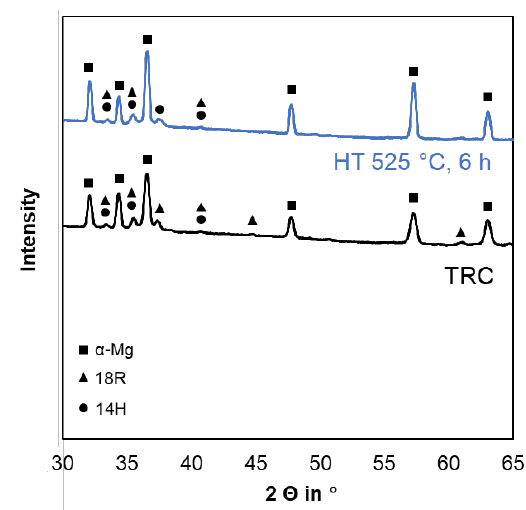
Figure 2. Results of the X-ray diffraction (XRD) analysis of the twin-roll cast (TRC) and the heat-treated (HT) state (525 °C, 6 h).